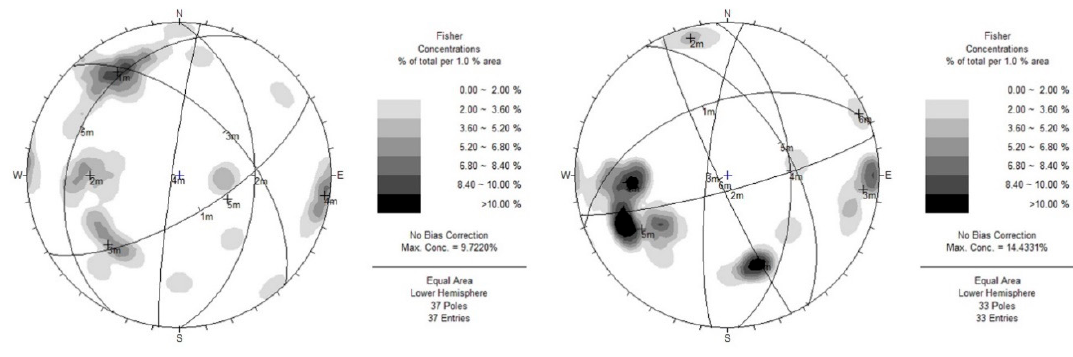
Figure 4. Poles plot of two di ff erent surveys along scanlines.